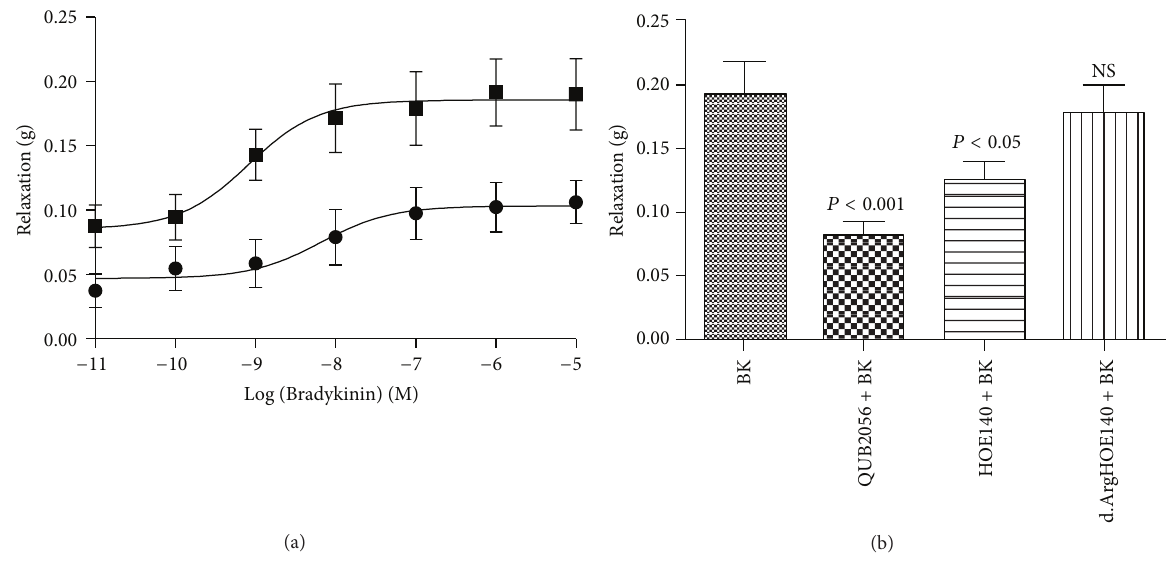
Figure 5: (a) Bradykinin dose-response curves using rat arterial smooth muscle in the absence ( ◼ ) and presence ( e ) of ranakinestatin-PPF (generic name QUB2056) at a single dose of 10 −6 M. (b) Relaxation effect of bradykinin on rat arterial smooth muscle at a single dose of 10 −6 M and the effect of pretreatment with ranakinestatin-PPF (QUB 2056) at 10 −6 M ( 𝑃 < 0.001 ), the bradykinin B 2 -receptor antagonist, HOE140 (3 × 10 −7 M) ( 𝑃 < 0.05 ), and the bradykinin-B 1 -antagonist, desArg-HOE-140 (3 × 10 −7 M) (NS—not significant). All data points represent the mean ± SEM of seven